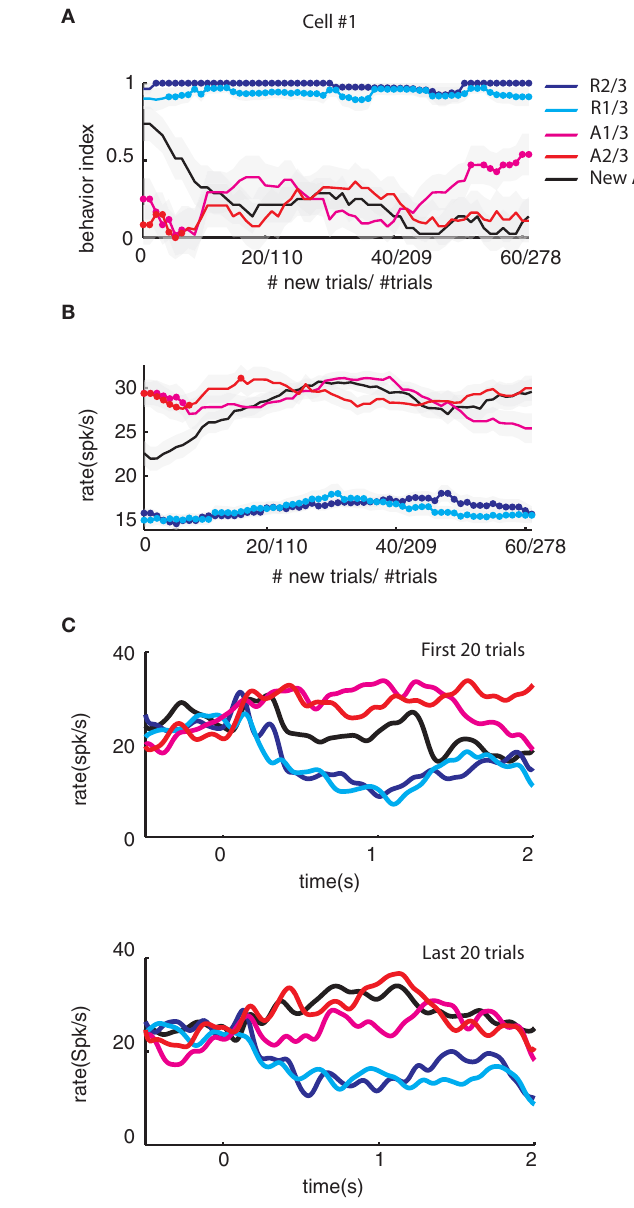
trials. The cell was recorded at the same time as the behavior shown in (A) ; the time scales of neural and behavioral changes of this neuron are equal. (C) The peri-stimulus time histogram (PSTH) of the SNpr neuron from (B) during the fi rst twenty trials of recording (top) and the last 20 trials of recording (bottom). PSTHs were constructed by summing activity across trials in a 1 ms resolution aligned at cue presentation (time = 0) and then smoothed with a Gaussian window (SD of 40 ms). (D–F) Same as (A–C) for a different SNpr cell and a different recording session. To enable visualization of the sharp response to some of the events, the PSTH of this cell was smoothed with SD = 20 ms. Unlike the fi rst neuron (A–C) , the neural responses of this cell to the familiar cues and new cue are different even after saturation of the